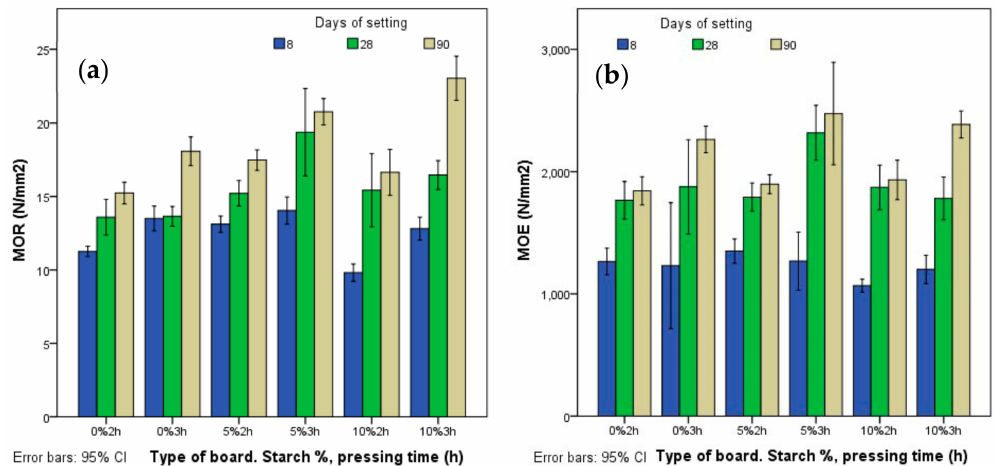
Figure 7. Modulus of rupture (MOR) ( a ) and modulus of elasticity (MOE) ( b